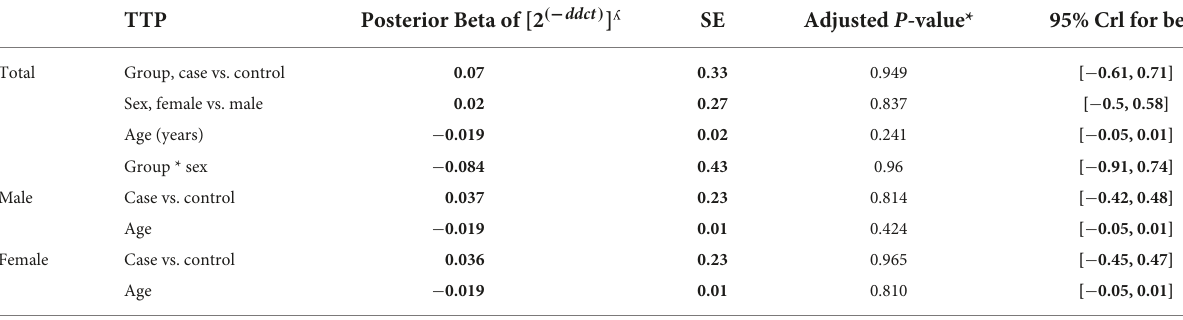
*Estimatedfromfrequentistmethods;CrI,credibleinterval; ,powertransformationvalueestimatedfromBox-coxorYeo-Johnsonmethod.